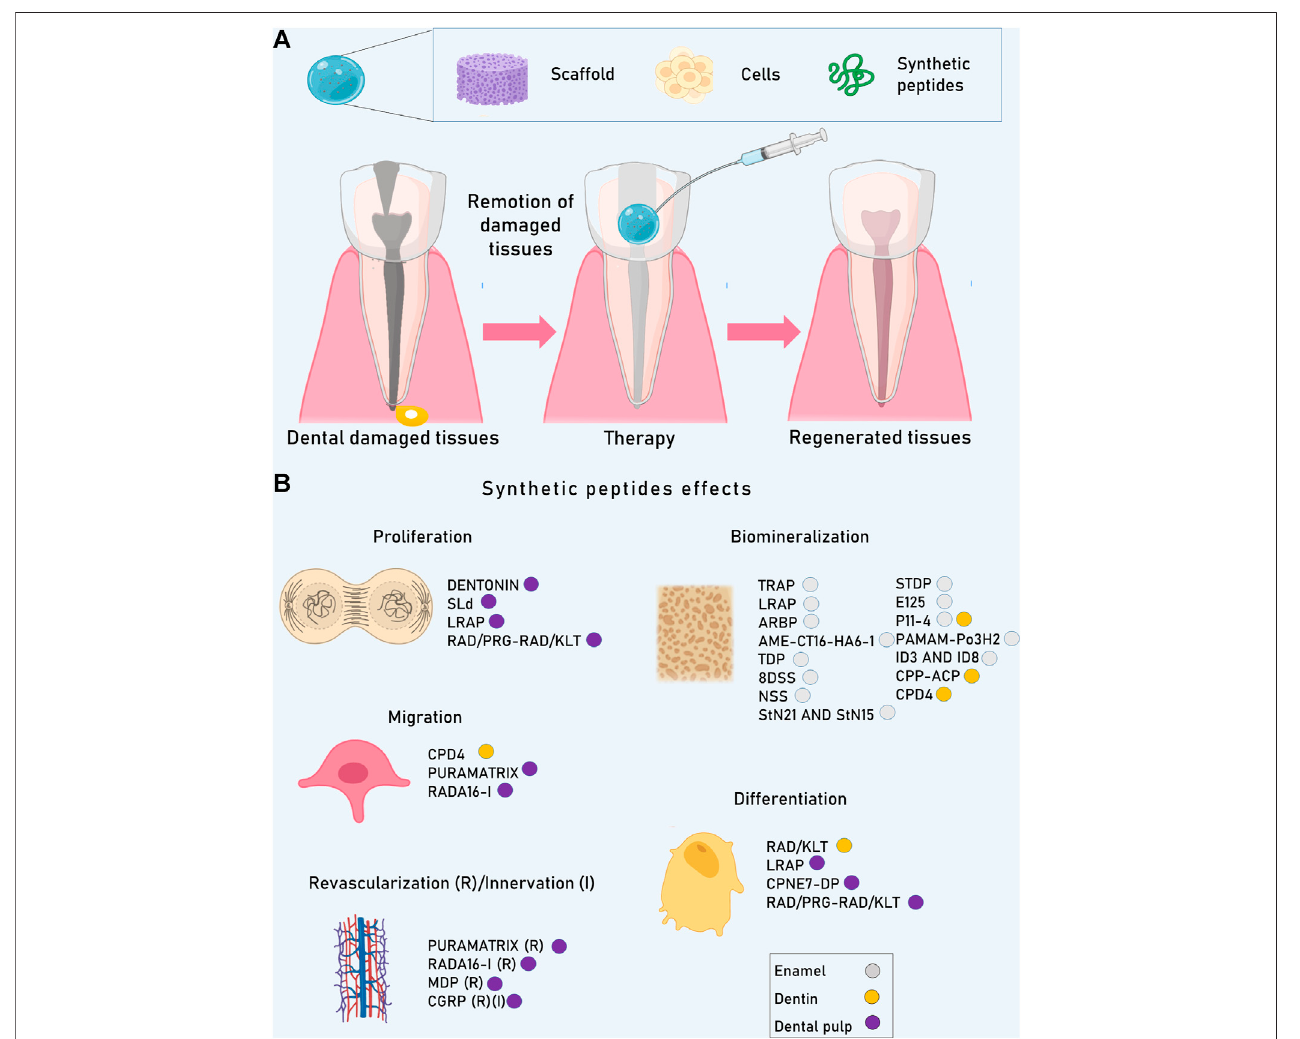
FIGURE 1 | The combined use of scaffolds, cells, and bioactive molecules such as SP is considered the best approach to achieve tissue regeneration. (A) Dental organscanbedamagedprincipallybycaries.Dependingonthedamagelevel,enamel,dentinorevenpulpcanbeinjured.Advancesinthe fi eldofSPcouldbebene fi cial to treat and regenerate lost tissues. (B) SP can induce diverse cellular processes in dental tissues as they can in fl uence cell behavior and also can modify scaffold properties, giving as a result the enhancement of cell proliferation, migration, revascularizatión, innervation, differentiation, and biomineralization.